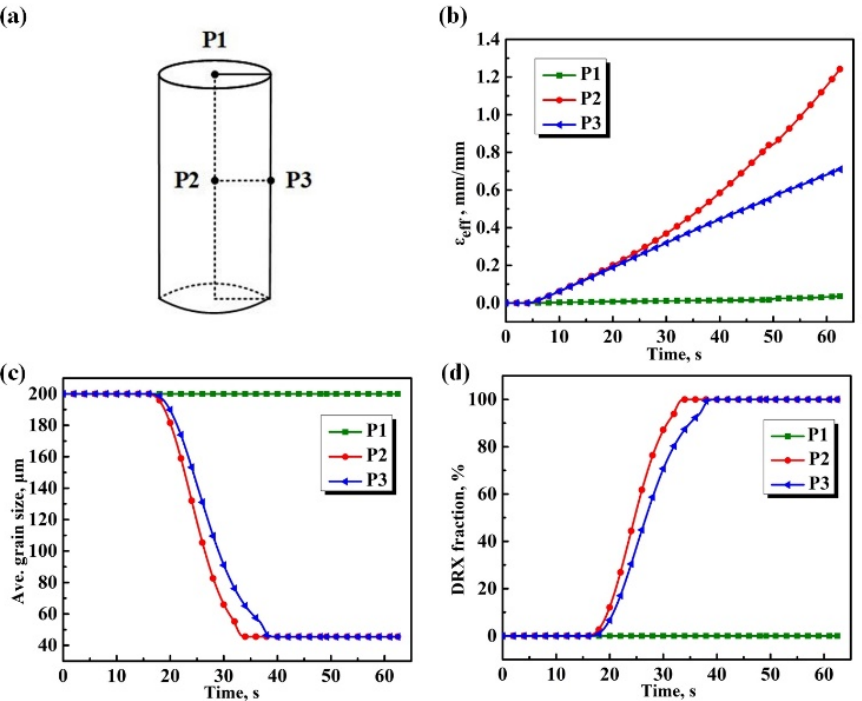
Figure 12. ( a ) Different tracking points; ( b ) effective strain; ( c ) average grain size; ( d ) DRX fraction curves.